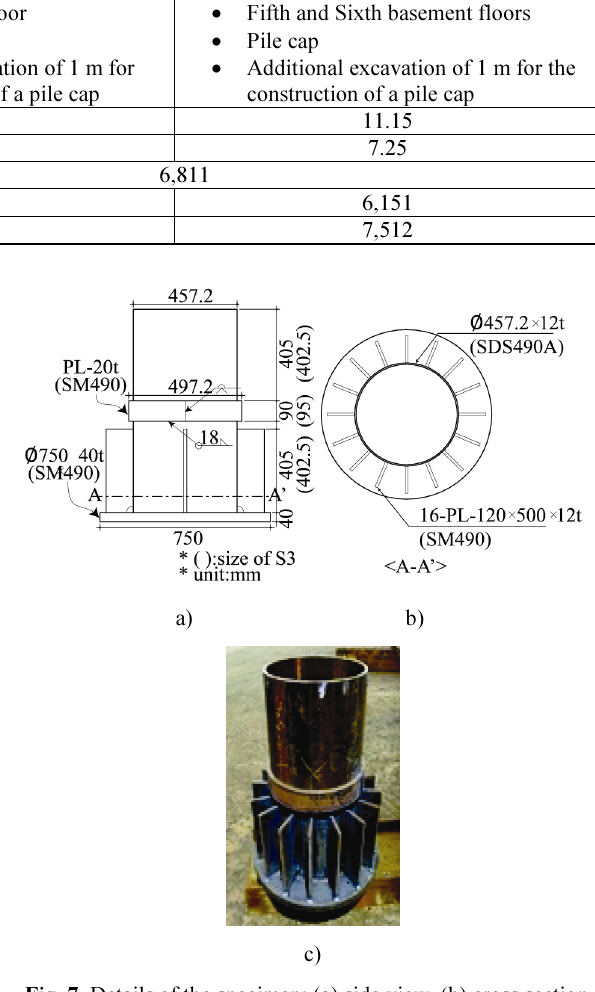
Fig. 7. Details of the specimen: (a) side view, (b) cross section and (c) photo of the